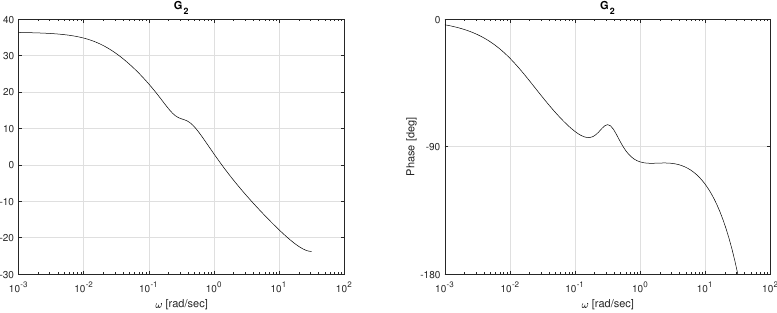
Figure 9. Frequency characteristics of the investigated systems—magnitude ( left ), phase ( right